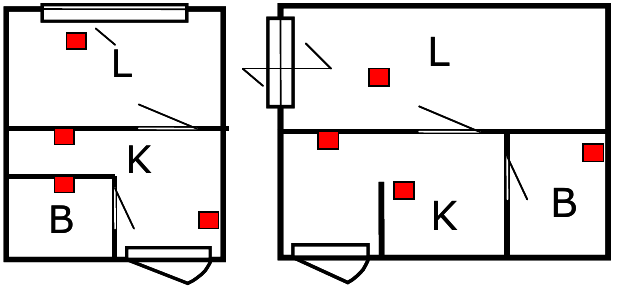
Figure 9. The IR sensor layout in the room of home A (left) and B (right) for the experiment. The IR sensor indicated by a square is installed at each room. The living (L), kitchen (K), bedroom (B), and the entrance are